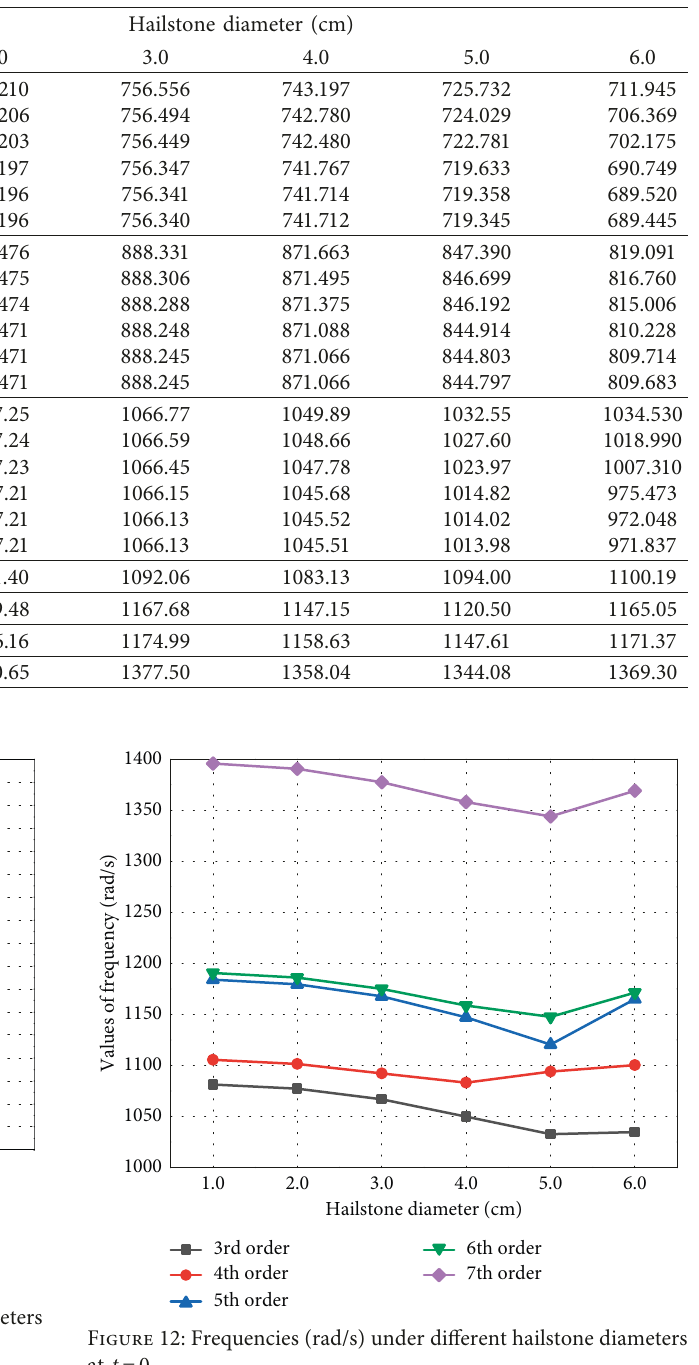
Table 4: Frequencies (rad/s) under different hailstone diameters and time instants.